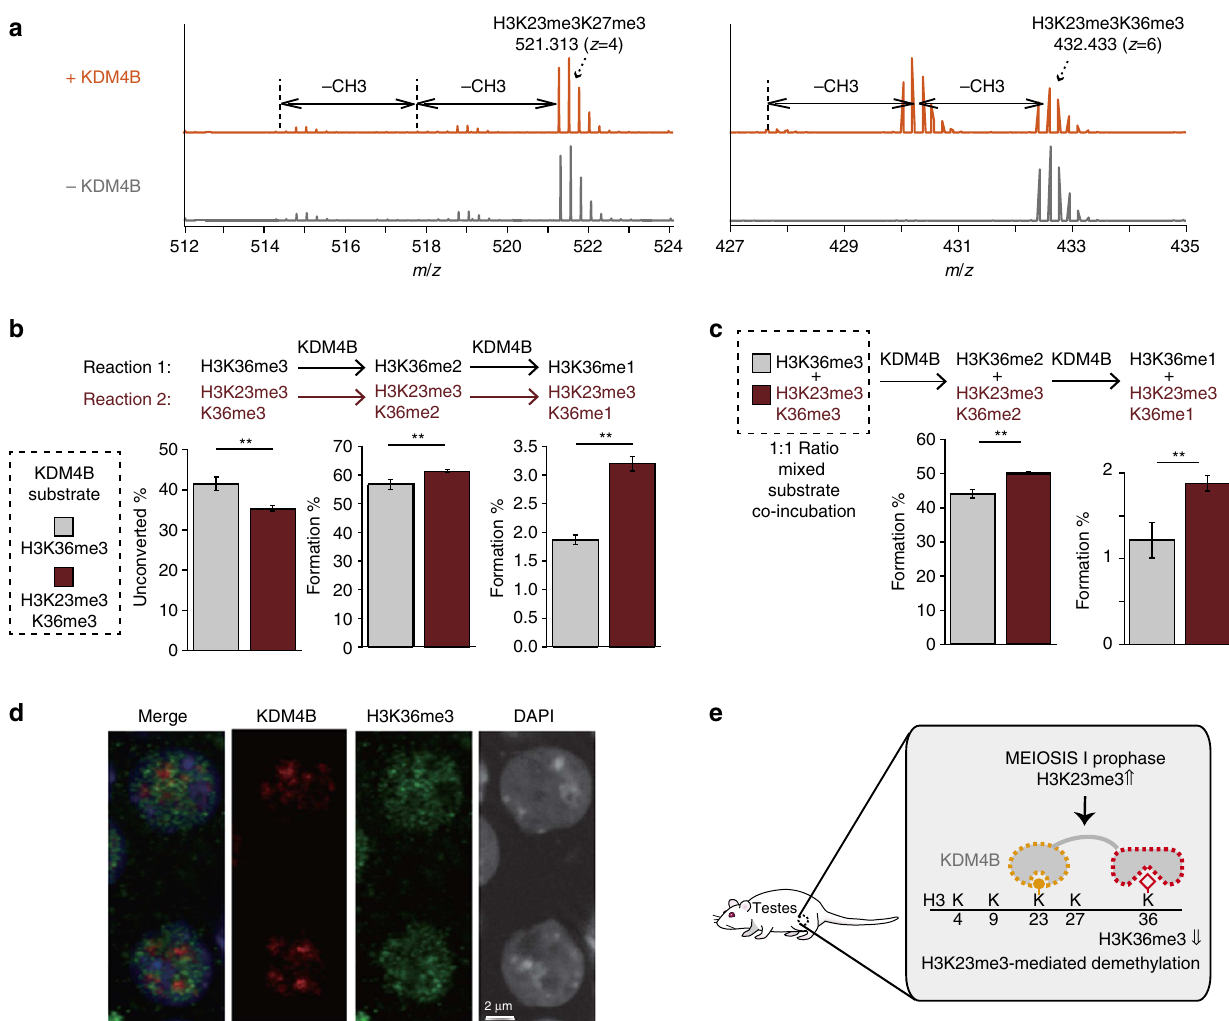
Figure 6 | H3K23me3 binding stimulates H3K36 demethylation by KDM4B. ( a ) MS analysis of demethylation reaction by KDM4B full-length protein. H3(17–34)K23me3K27me3 or H3(20–42)K23me3K36me3 peptides were used as substrates. Negative controls without KDM4B enzyme were shown side-by-side. The shown spectrums of only one charge state at one time point (H3K27me3 peptides: þ 4 charge state, 120min; H3K36me3 peptides: þ 6 charge state, 30min) display representative trends of all three charge states at three time points for each peptide. ( b ) Co-existing H3K23me3 increases H3K36me3 conversion to H3K36me1/2 by KDM4B. Product formation was measured by MS. Errors represent s.d. from three charge states of the same peptide. Student’s t -test was performed (** P o 0.01). ( c ) KDM4B preferentially demethylates dually modified peptide in 1:1 (5 m M:5 m M) ratio mixture of H3K36me3 and H3K23me3K36me3 substrate. Site and level of demethylation was quantified by MS. Errors represent s.d. from three charge states of the same peptide. Student’s t -test was performed (** P o 0.01). ( d ) KDM4B (red) shows distinct localization with H3K36me3 (green) by indirect immunofluorescence in rat primary spermatocytes (scale bar, 2 m m). ( e ) Proposed model of H3K23me3-mediated H3K36me3 demethylation by KDM4B during